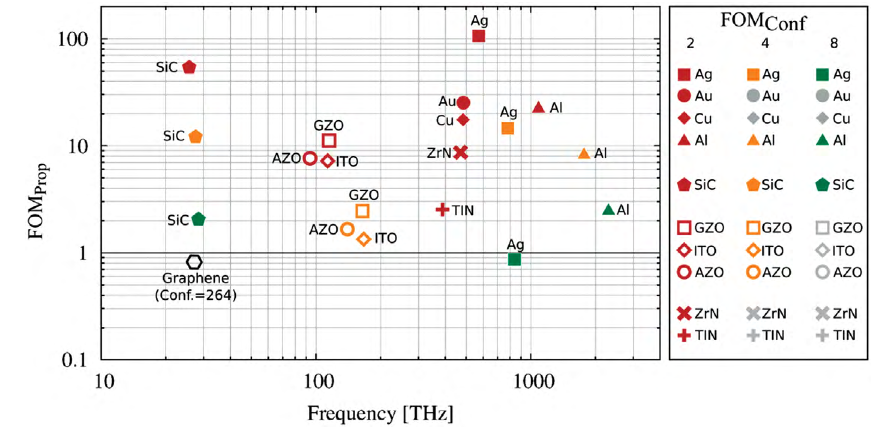
) vs. frequency for different materials at three different FOM Prop